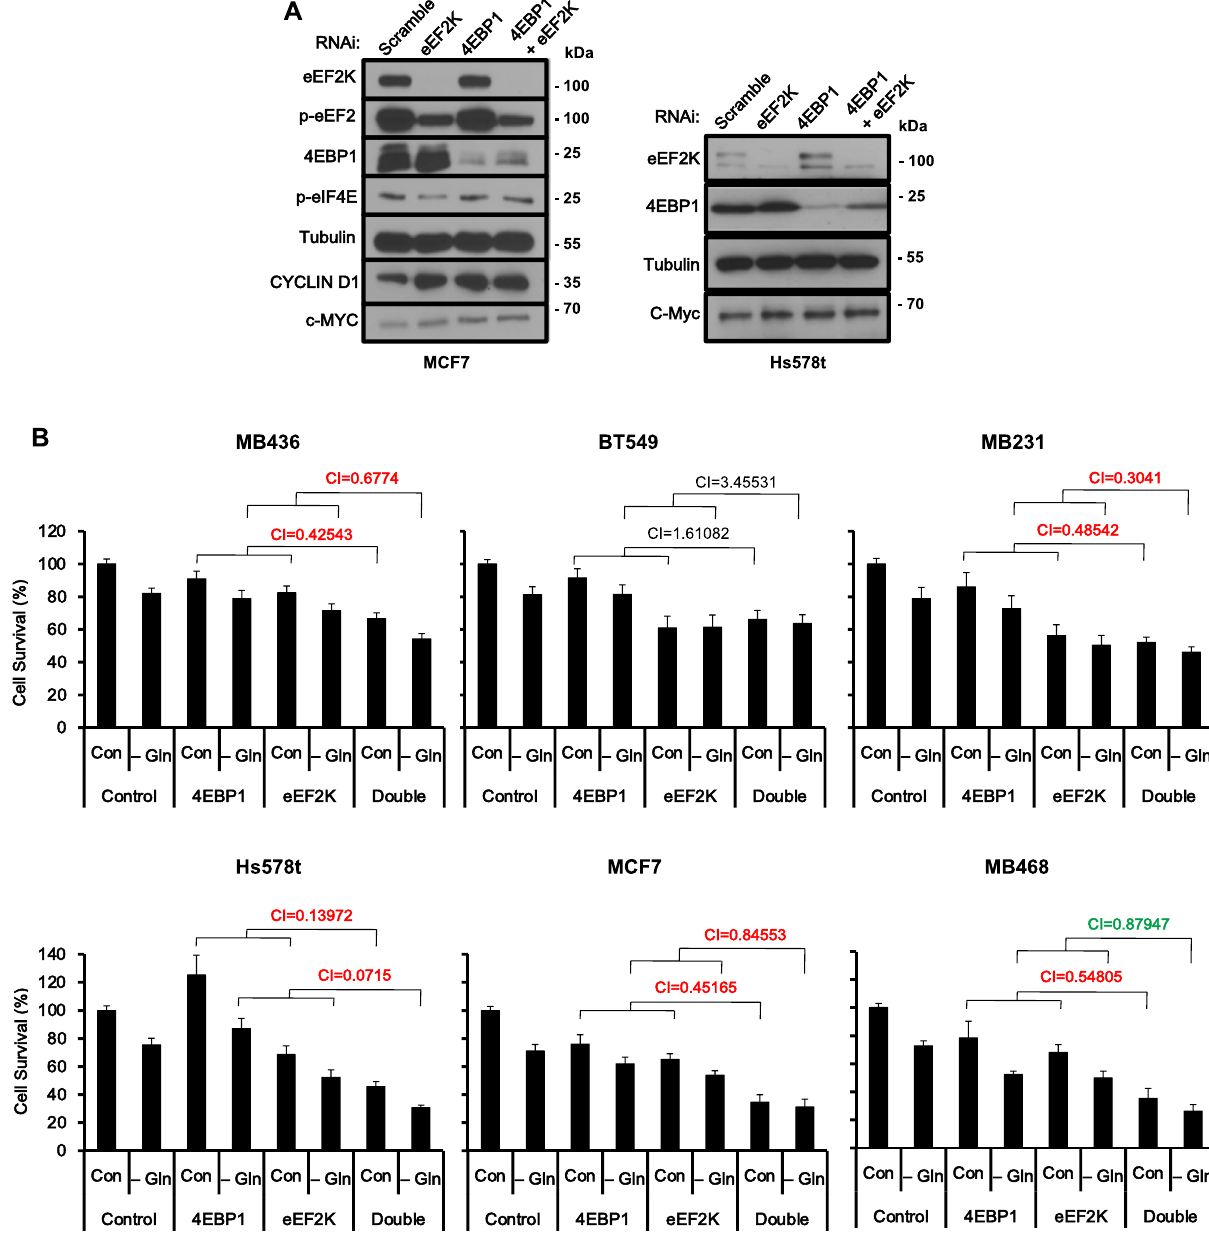
Figure 3. Induction of CYCLIN D1 and c-MYC and synergistic inhibition of breast cancer cell growth following combined knockdown of eEF2K and 4EBP1 under nutrient deprivation. ( A ) CYCLIN D1 and c-MYC expression following transient RNAi-mediated knockdown of eEF2K and/or 4EBP1 in MCF7 (left) and Hs578t (right) cells. ( B ) Cell growth following combined knockdown of eEF2K and 4EBP1 in indicated breast cancer cell lines under nutrient deprivation. CIs were analyzed by CompuSyn software: synergy (CI < 0.85; red), additive (0.85 < CI < 1.1; green), and antagonistic (CI > 1.1;